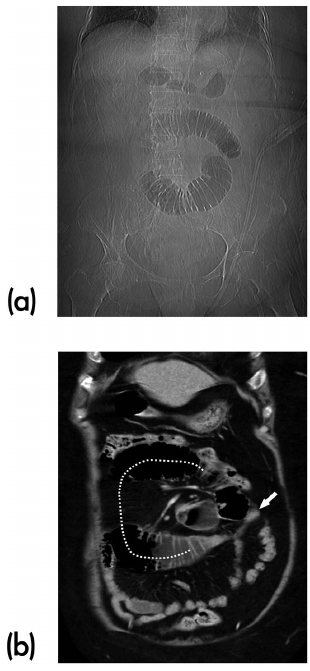
Figure 3. Closed-loop sign. (a) Abdominal radiograph shows a C- shaped configuration of the bowel loops in the center of the abdomen, a finding that indicates closed-loop obstruction. (b) On coronal MDCT image, the affected loops (dotted line) are filled with gas. The stretched mesenteric vessels converging toward the site of torsion (arrow).